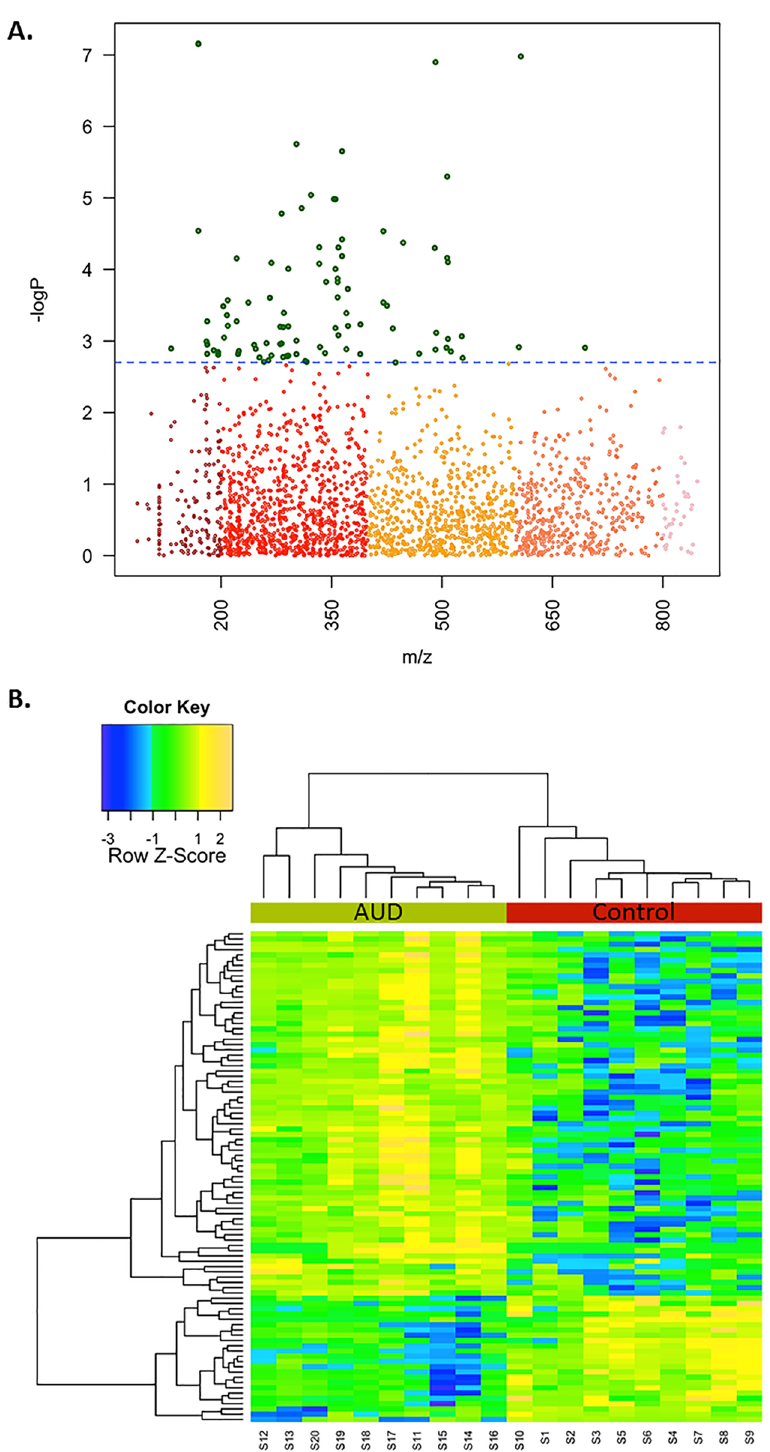
Fig 4. Differentially expressed features were identified by FDR analysis. FDR analysis was performed on the features identified in the BAL fluid of 10 alcoholic subjects and 10 controls. A. The Manhattan Plot demonstrates that 93 of the 2688 m/z features exceed the significance threshold (q = 0.05), denoted by the dashed line. B. Hierarchical clustering analysis is depicted in a heat map to demonstrate the separation of the two groups by differential expression patterns of 93